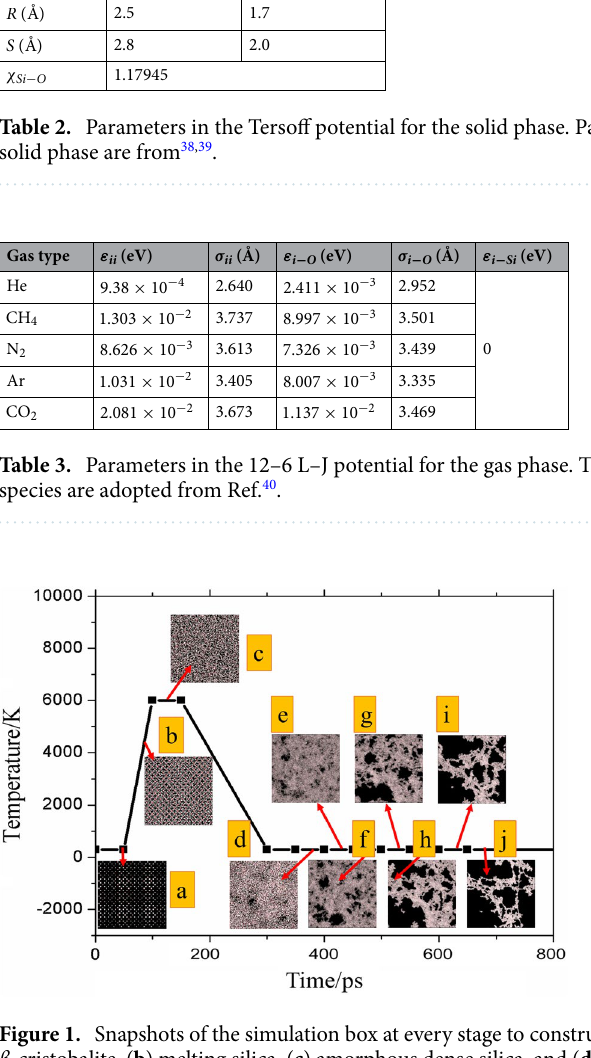
Figure 1. Snapshots of the simulation box at every stage to construct the porous aerogel: ( a ) crystalline β -cristobalite, ( b ) melting silica, ( c ) amorphous dense silica, and ( d – j ) porous